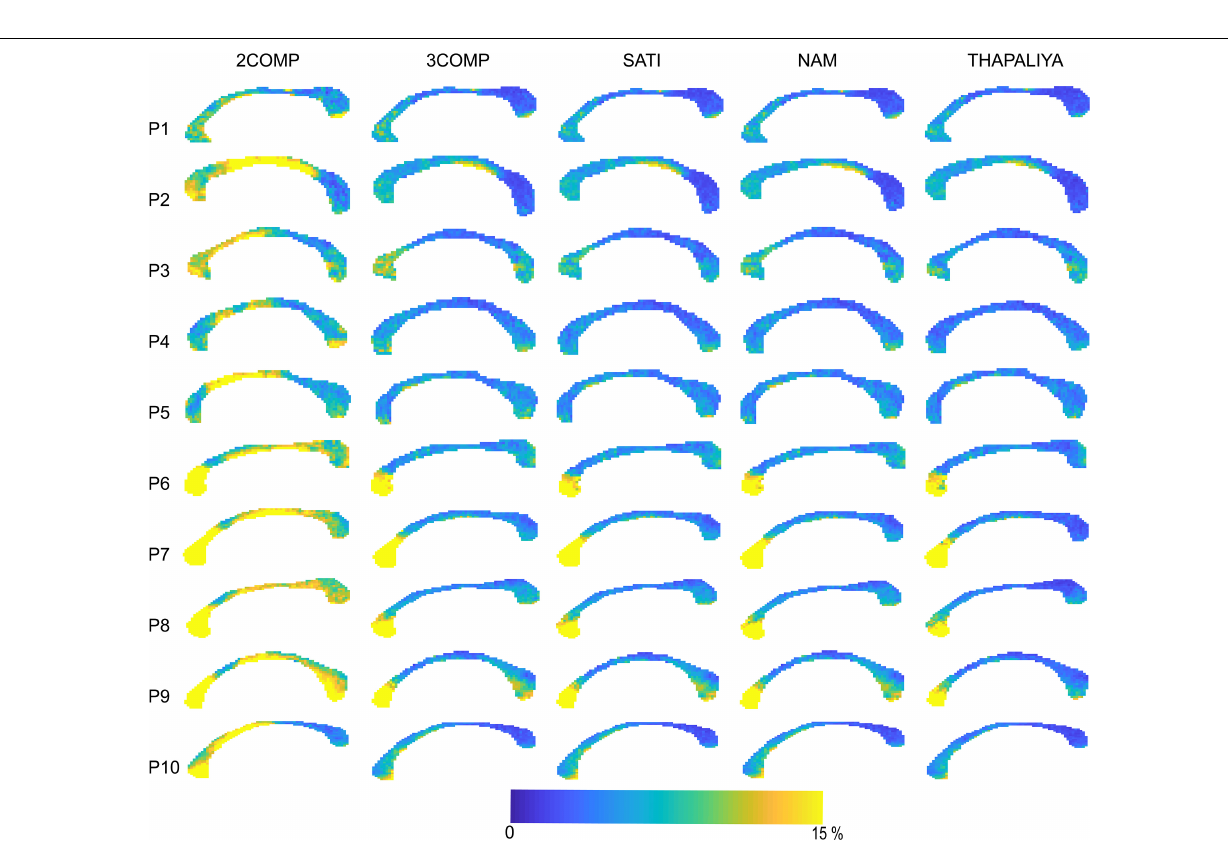
Frontiers in Neuroscience |